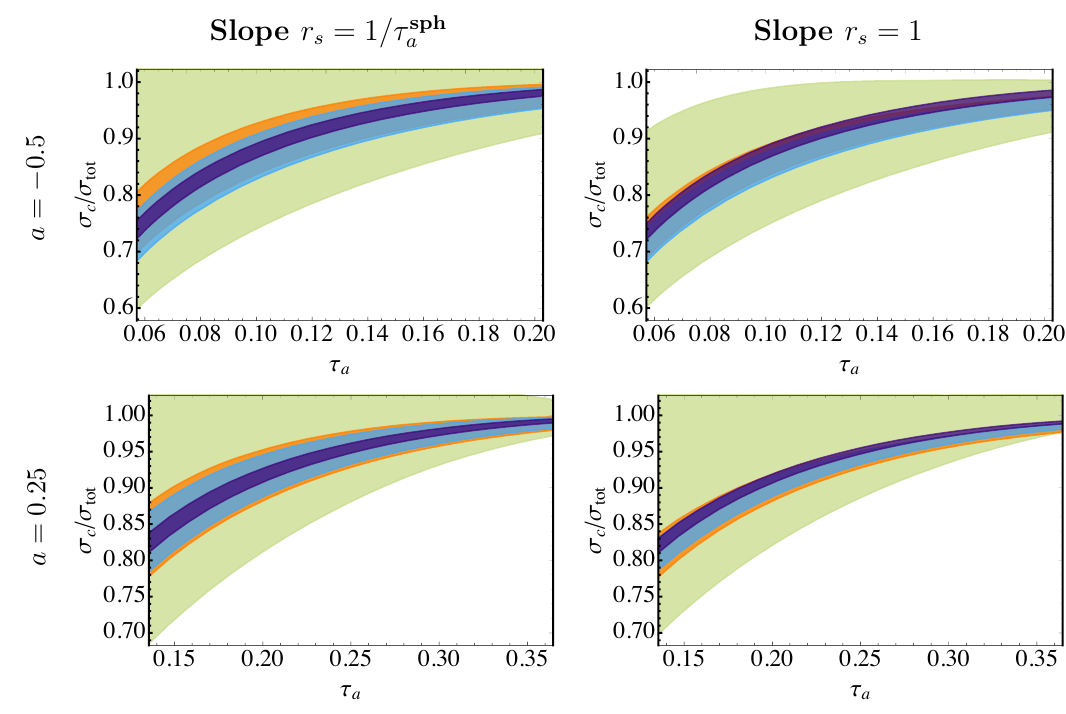
Figure 14 . Integrated angularity distributions for a = 0 : 5 and a = 0 : 25 at Q = m Z at NLL (cid:0) (green), NLL 0 + ( (cid:11) s ) (orange), NNLL+ ( (cid:11) s ) (blue), and NNLL 0 + ( (cid:11) 2 ) (purple) accuracy, with s O O O renormalon subtractions to the corresponding orders. The distributions have been obtained with the slope parameter r s = 1 =(cid:28) sph (left) and r s = 1 a